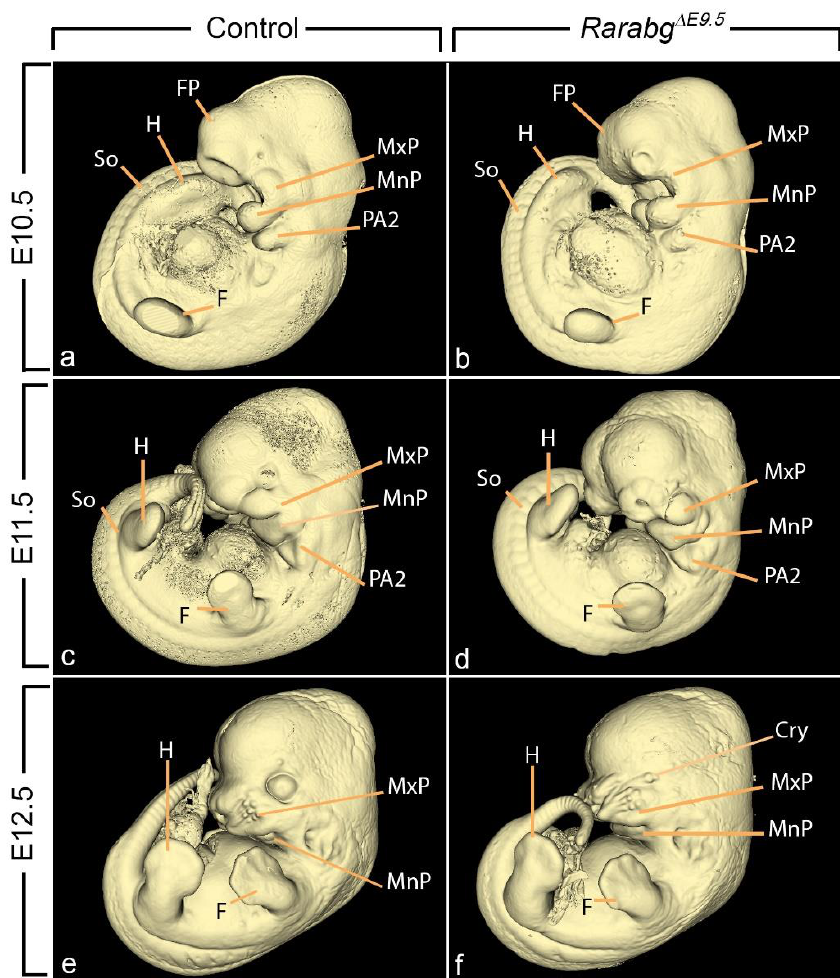
Figure 2. Left lateral views of control embryos ( a , c , e ) and Rarabg ΔE9.5 mutant littermates ( b , d , f ) at E10.5, E11.5, and E12.5, as indicated. Cry, cryptophthalmos; F, forelimb bud; FP, frontonasal process; H, hindlimb bud; MxP and MnP, maxillary and mandibular processes of the 1st pharyngeal arch, respectively; PA2, 2nd pharyngeal arch. So, somite. Same magnification in ( a – f ).